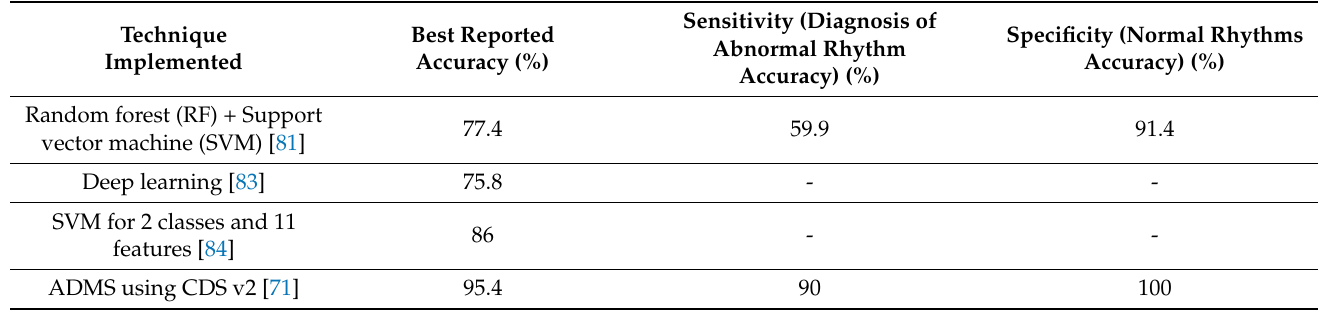
Table 5. CDS v2 and related published works are